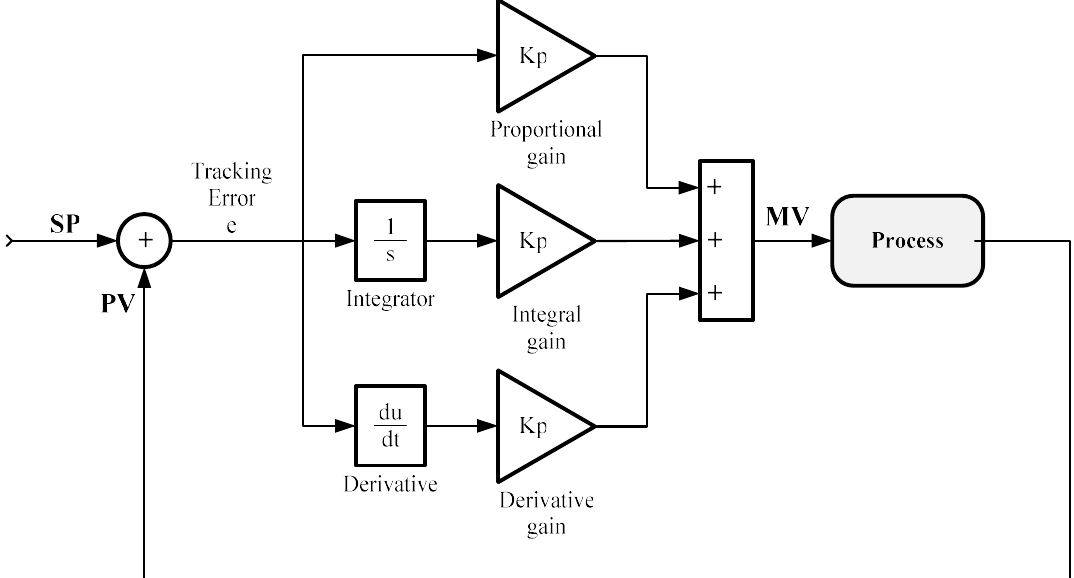
Figure 7. General form of the PID controller.